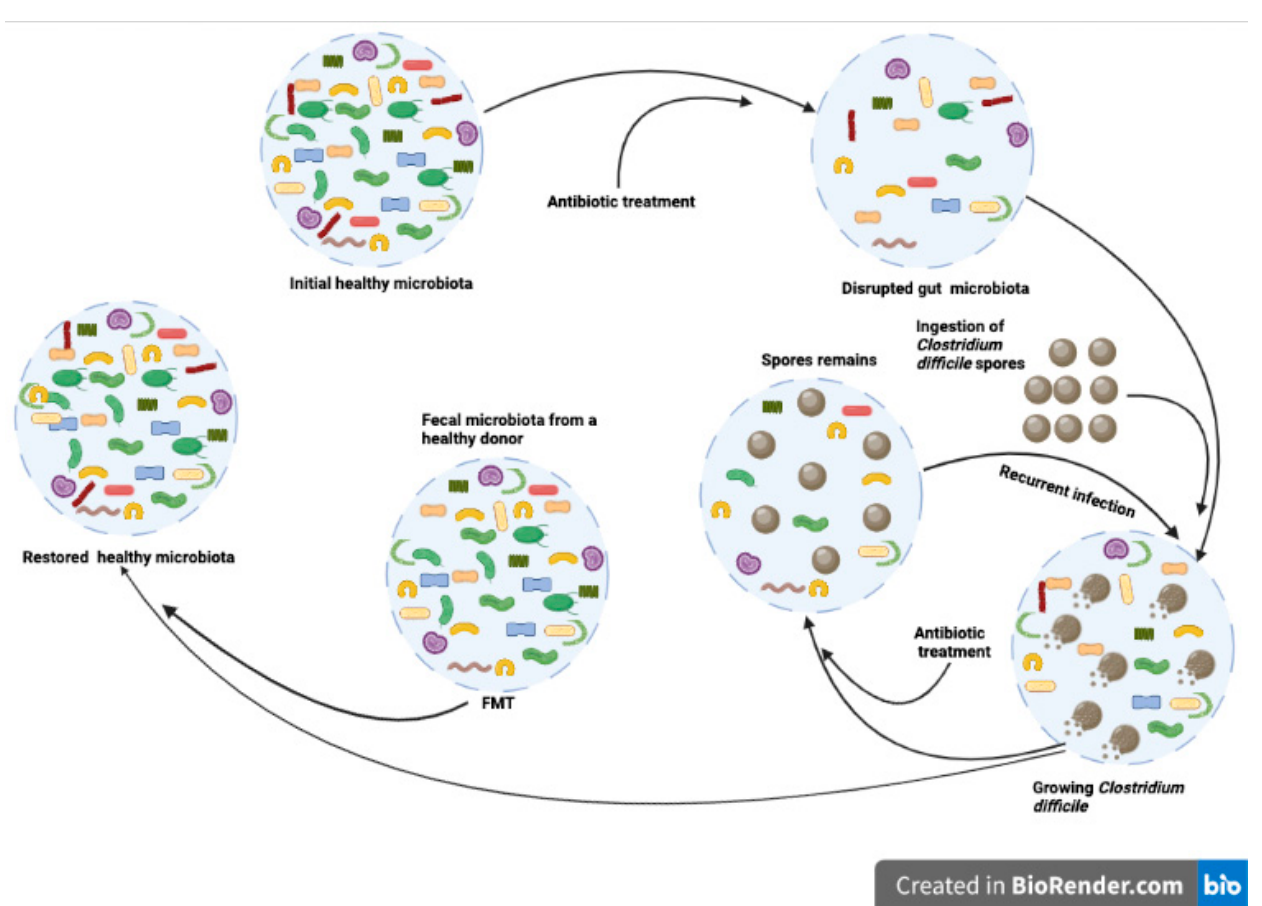
Figure 6. Possible mechanism of FMT therapy for Clostridium difficile infection. (Created with BioRender.com, accessed date 18 June